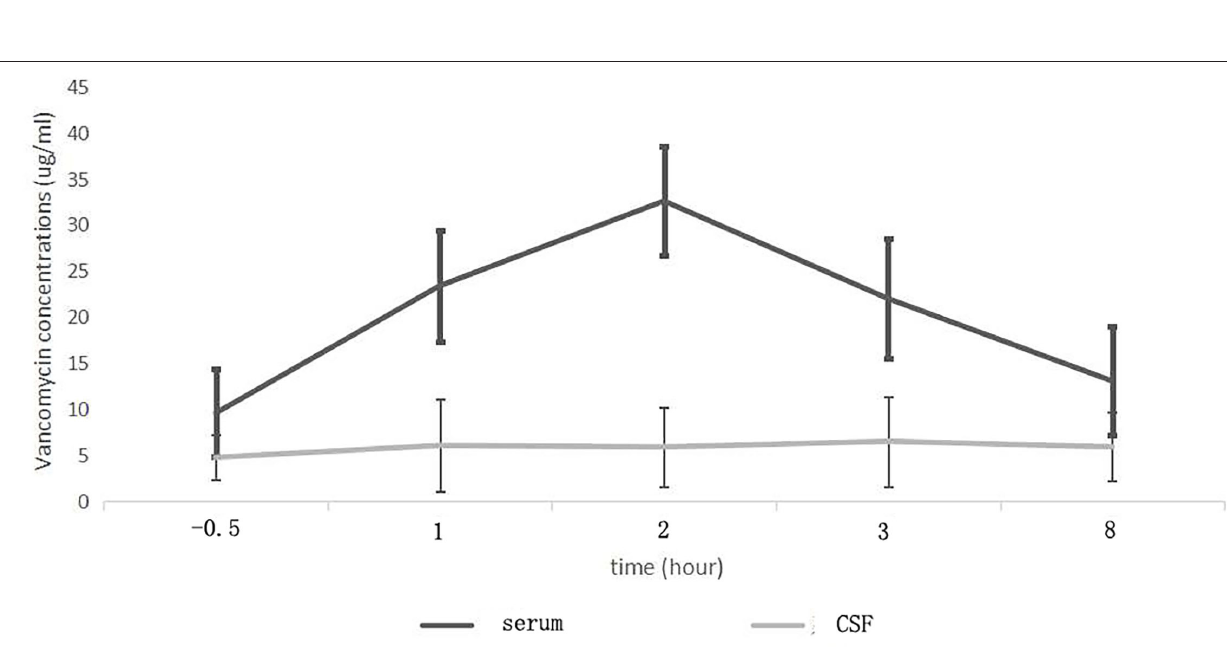
Frontiers in Neurology | www.frontiersin.org